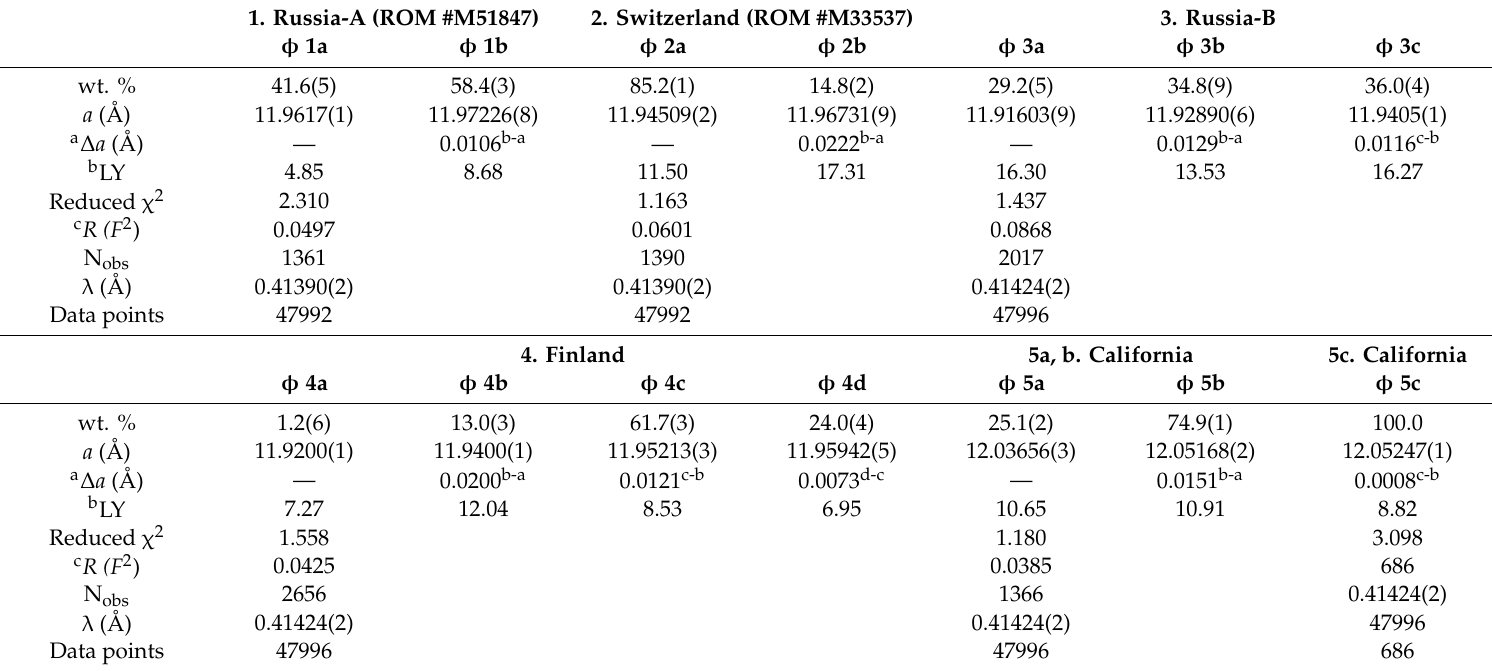
Table 3. High-resolution powder X-ray di ff raction (HRPXRD) data and Rietveld refinement statistical indicators for five uvarovite